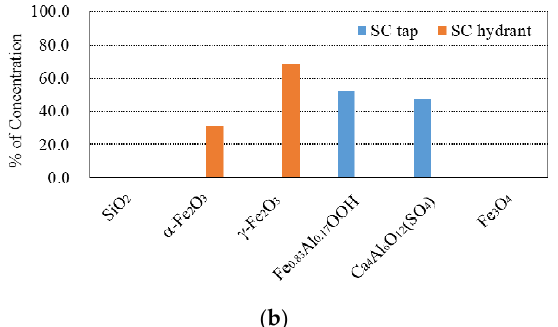
Figure 6. Results of experiments on the SC particulates. ( a ) Chemical concentration of the SC City particulates analyzed by ICP-MS; ( b ) Chemical composition of the SC City particulates analyzed by the XRD.